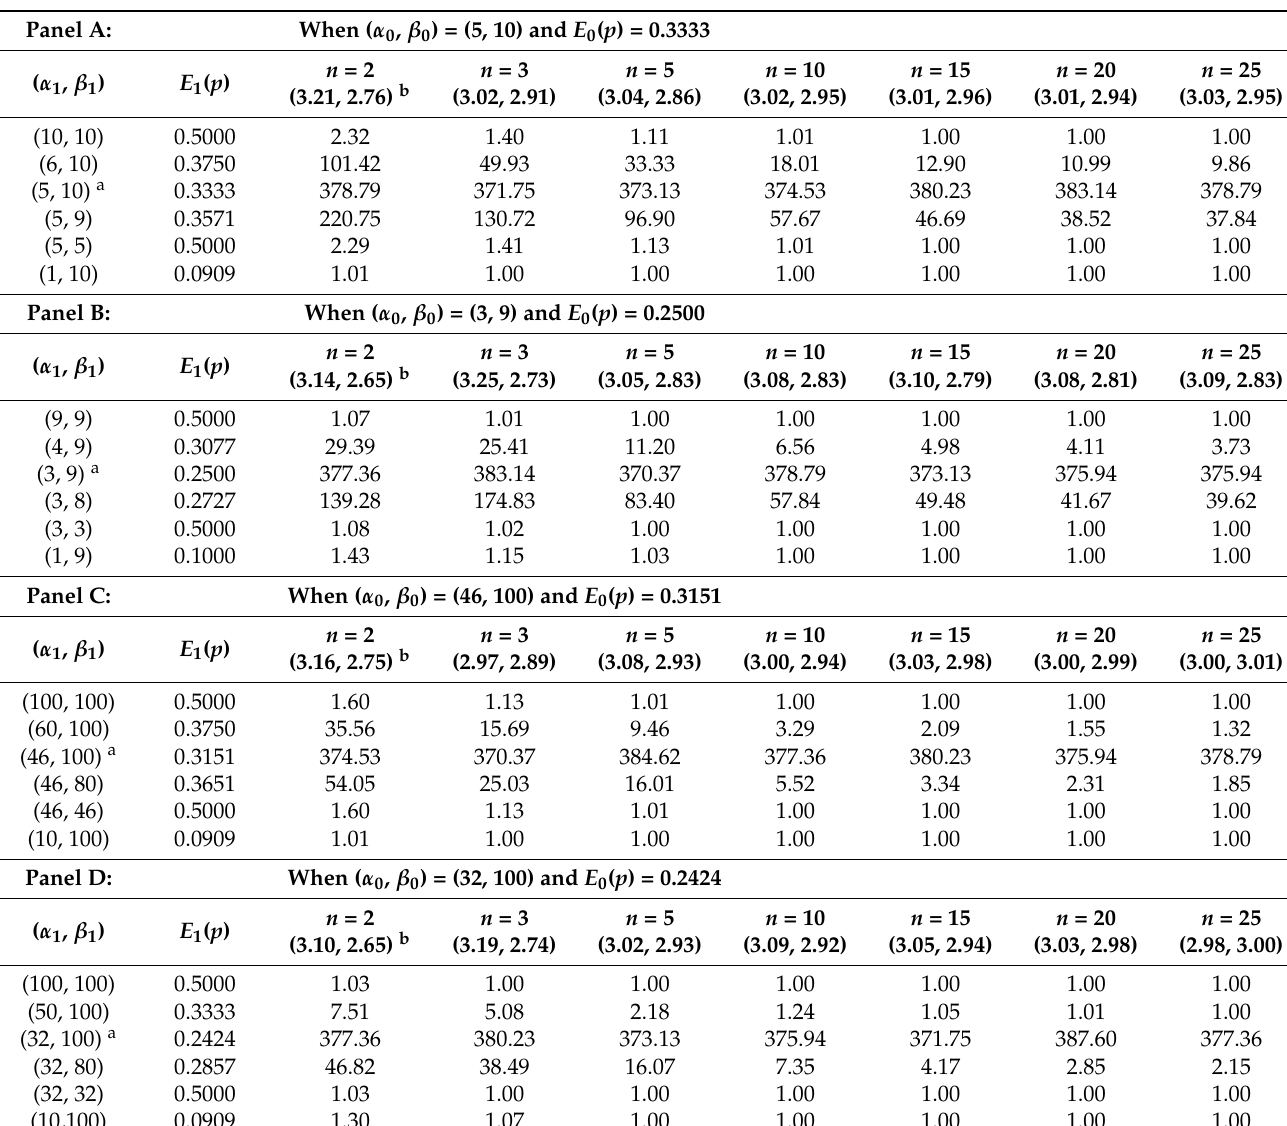
Table 4. The ARL 1 s of the proposed Bayesian EWMA variance chart ( λ =